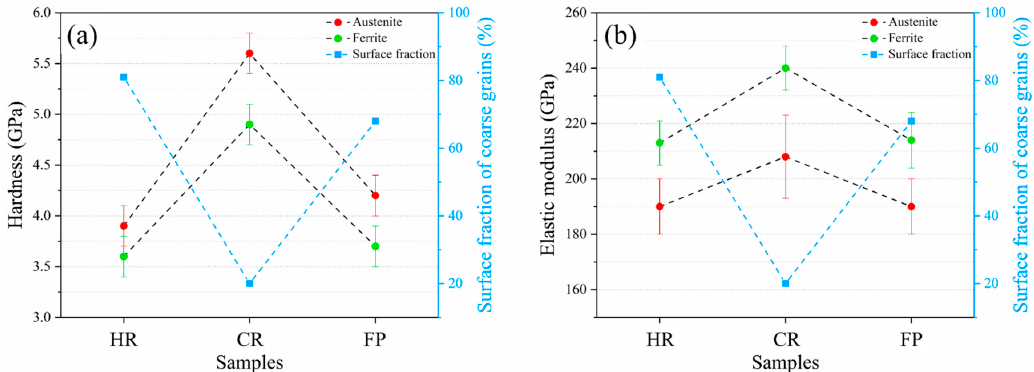
Figure 11. Intrinsic mechanical properties [( a )- H and ( b )- E ] evolution of both ferritic and austenitic phases and surface fraction of coarse grains during the DSS processing.